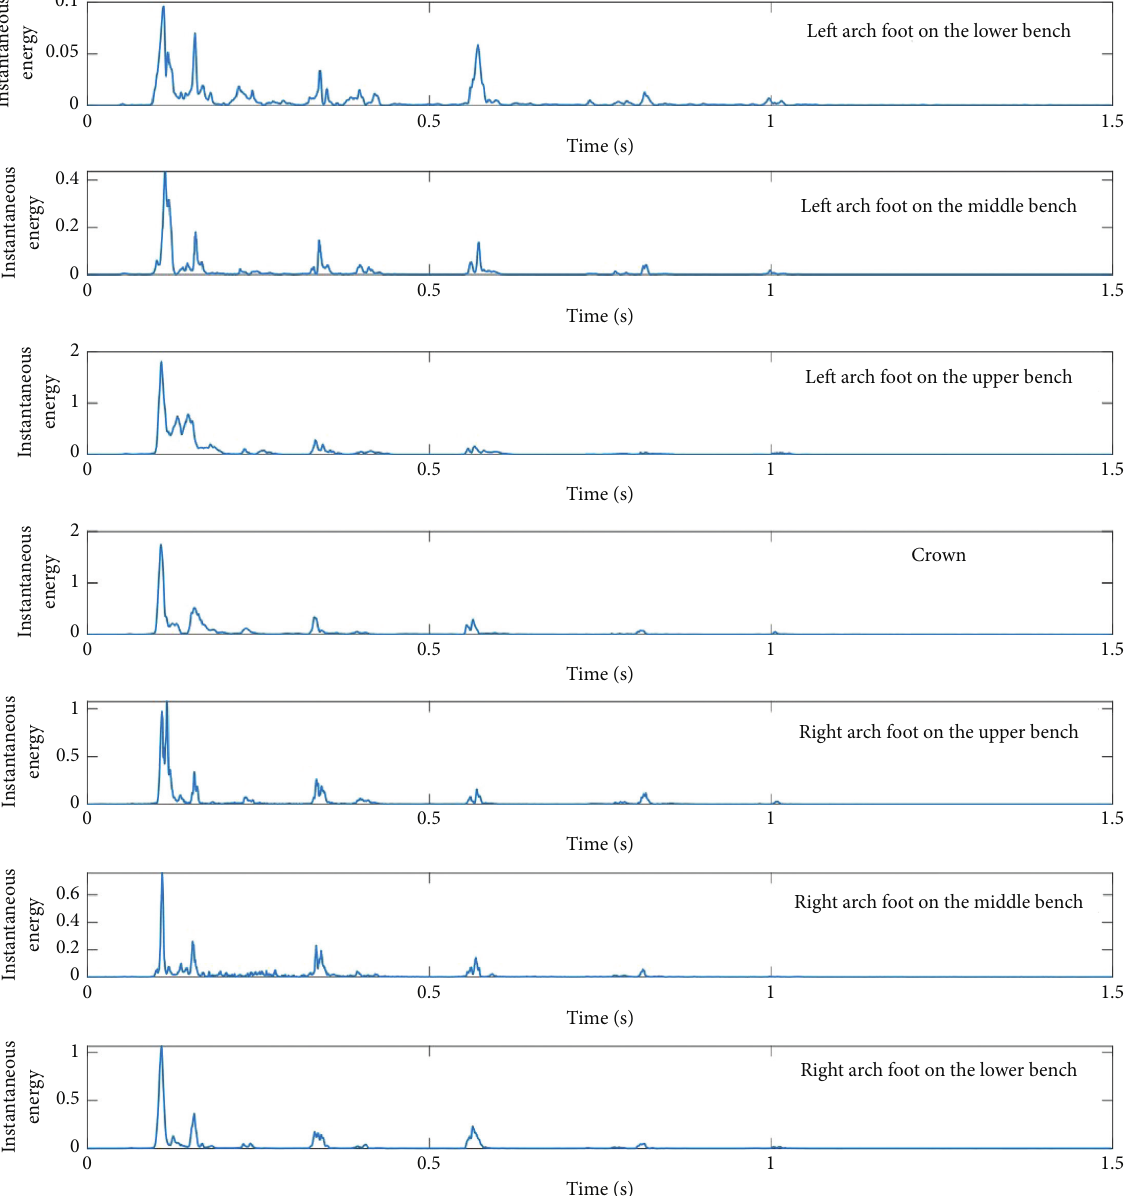
Figure 17: Instantaneous energy at different positions of